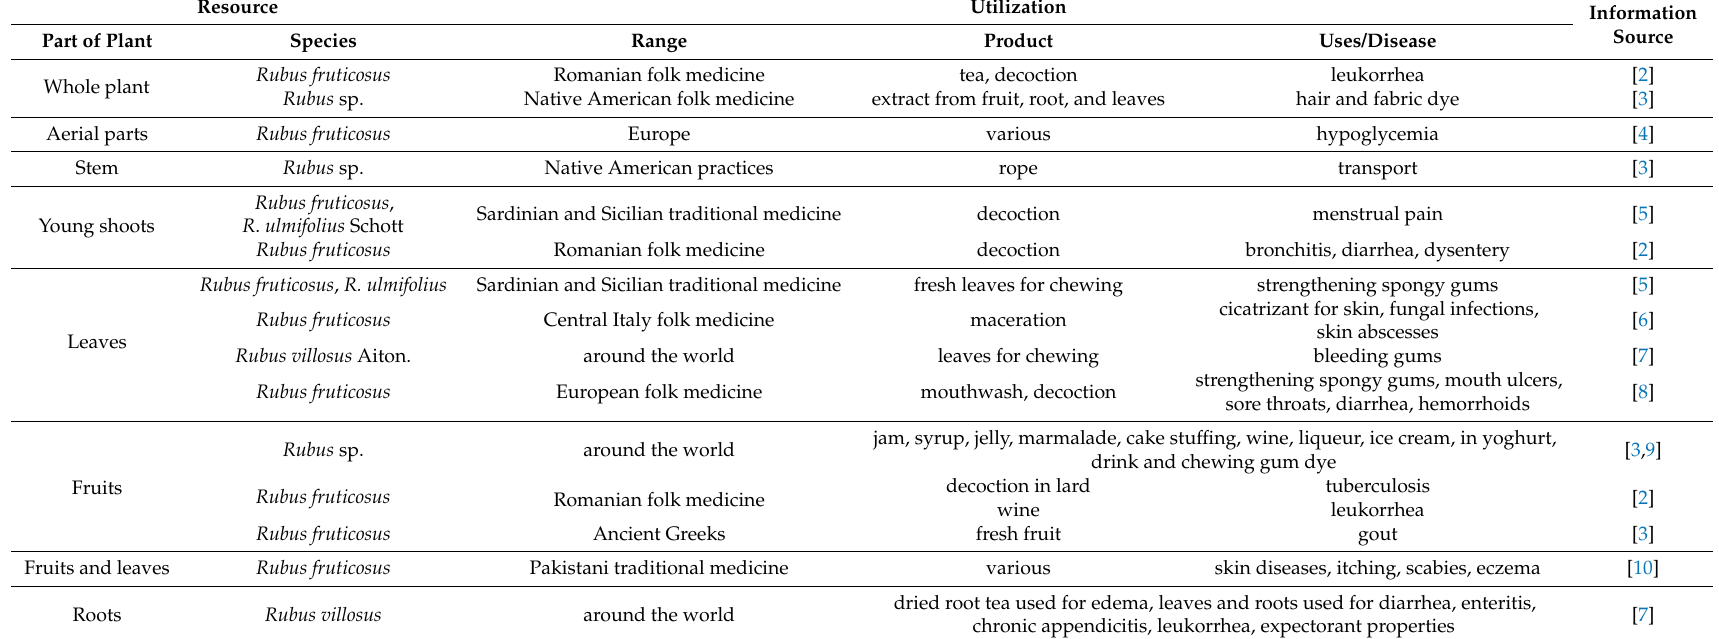
Table 1. The spectrum of traditional uses of